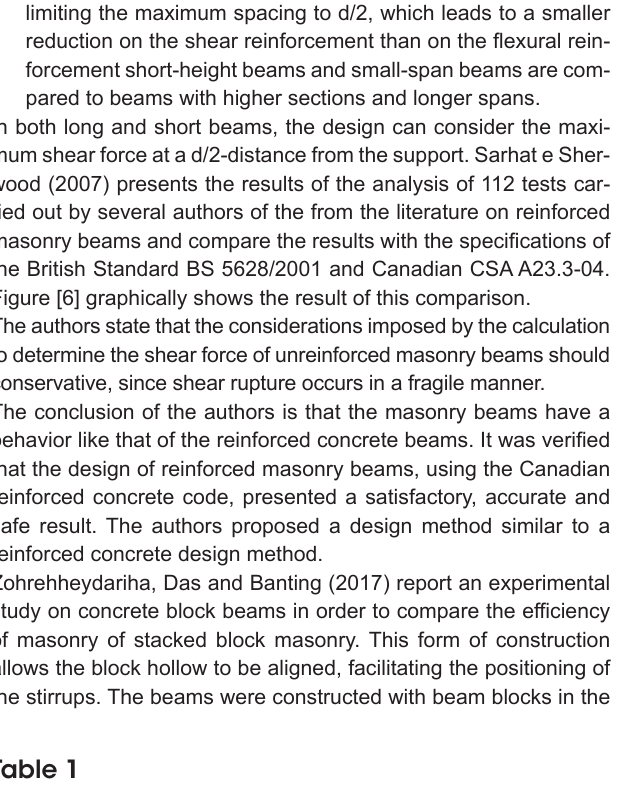
Reinforced masonry beam shear equations